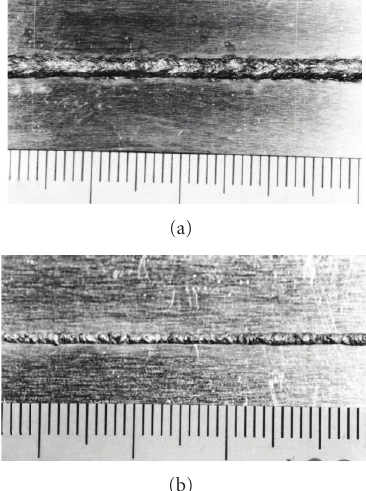
Figure 2: Face side (a) and root side (b) of alloy AA5083 welded using P = 4kW, S = 6m/min, Dd = 0, 15l/min